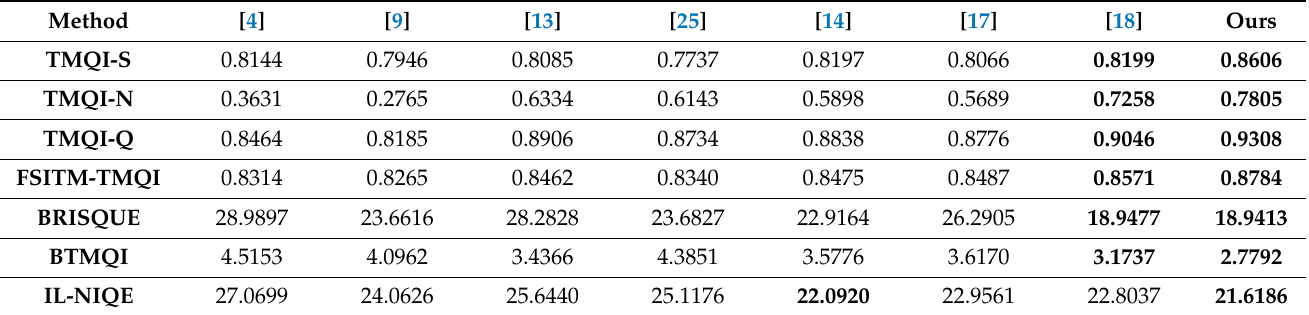
Table 3. Overall comparison of average TMQI, FSITM-TMQI, BRISQUE, BTMQI, and IL-NIQE using the twenty-two test